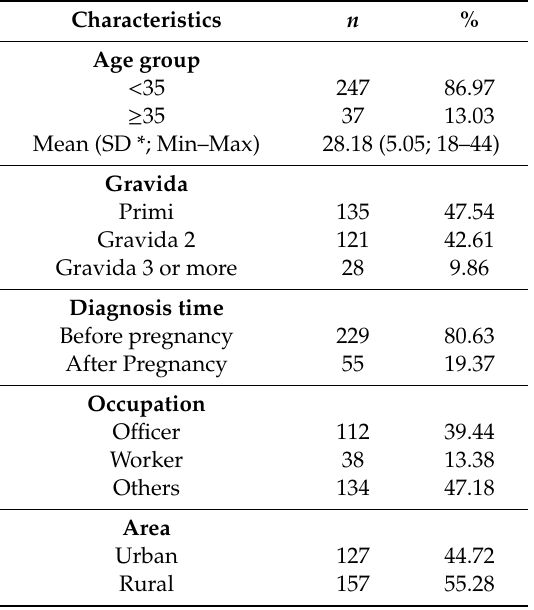
Table 1. Some selected characteristics of study patients ( n = 284).